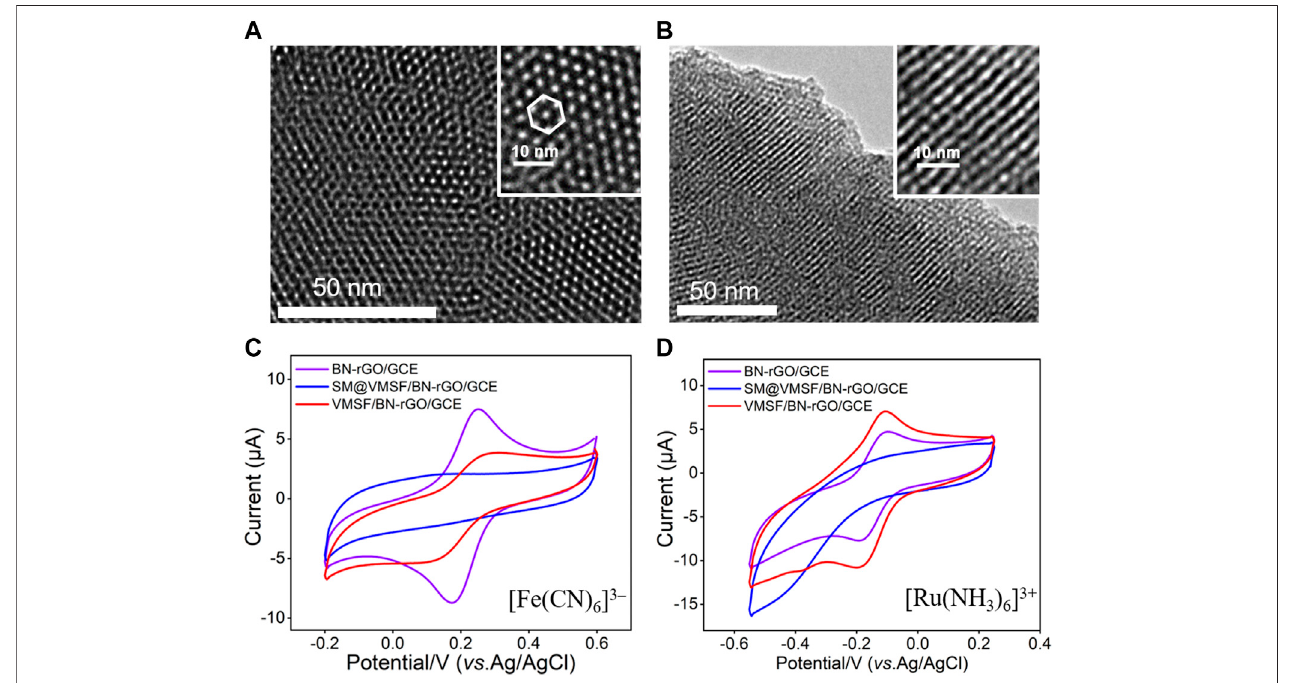
FIGURE 3 | Top-view (A) and cross-sectional view (B) TEM images of VMSF. The insets are corresponding magni fi ed images. CV curves obtained from the BN- rGO/GCE, SM@VMSF/BN-rGO/GCE and VMSF/BN-rGO/GCE electrodes in 0.05 M KHP containing 0.5 mM [Fe(CN) 6 ] 3 – (C) and [Ru(NH 3 ) 6 ] 3+ (D) . The scan rate was 50 mV/s.